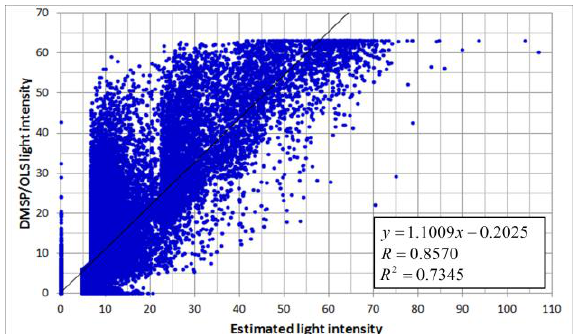
Figure 10. Correlation between light intensity of DMSP and